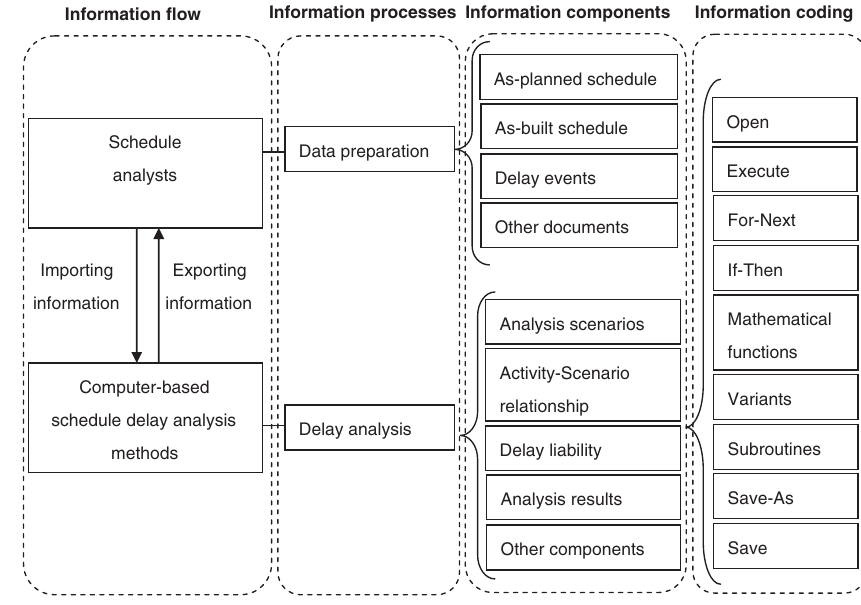
Fig. 1. Information fl ow between schedule analysts and computer-based schedule delay analysis